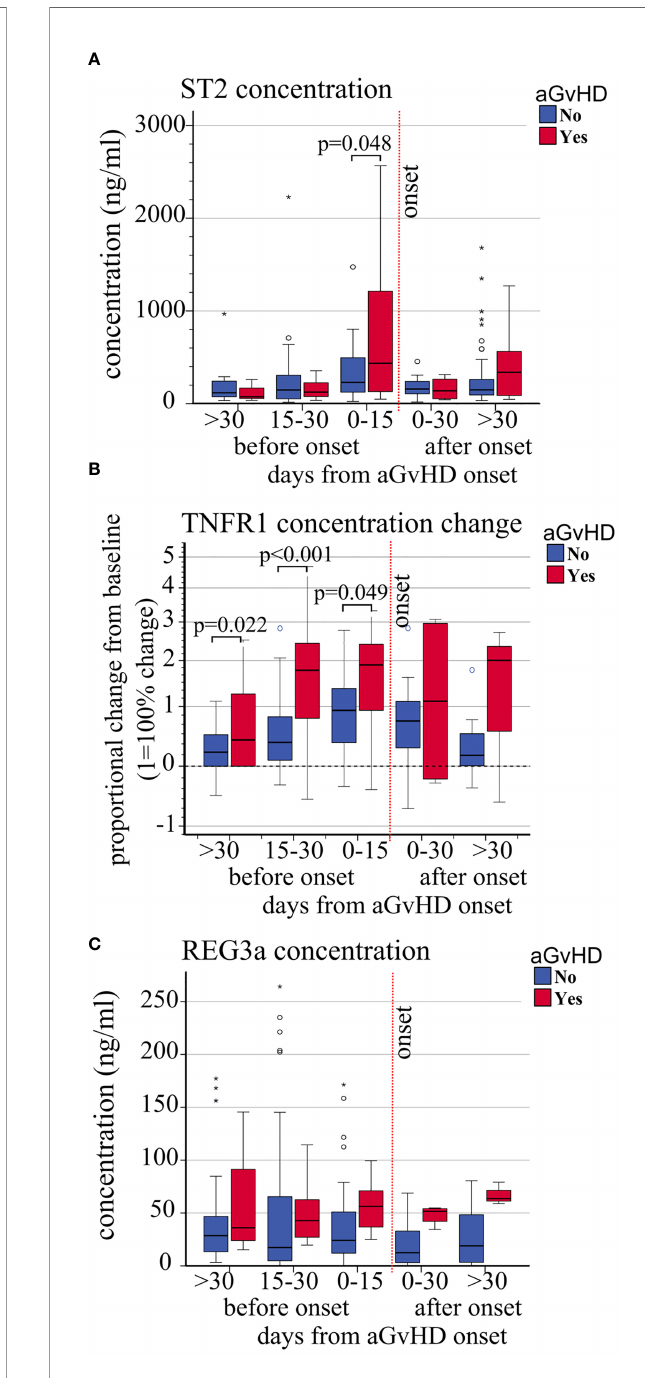
FIGURE 4 | Impactof aGvHD onset on the circulating levelsof ST2, sTNFR1, andREG3a. Variationsof (A) absolute ST2 plasma levelconcentrations(ng/ml), (B) sTNFR1 relative plasma concentrations, and (C) absoluteREG3a plasma level concentrations(ng/ml) from pre-transplantbaseline levels, inpatients with (red) andwithout (blue) aGvHD at different time points before andafter aGvHDonset. Dashed black line: pre-transplant levels; dashed red line: time ofaGvHD onset; circleand star-shaped dots represent outliers(>1.5 box length from median)and extreme values (>3 box length from median), respectively. Signi fi cant mean differences before the onset (p ≤ 0.05)between patients with aGvHD (red) and without (blue) are